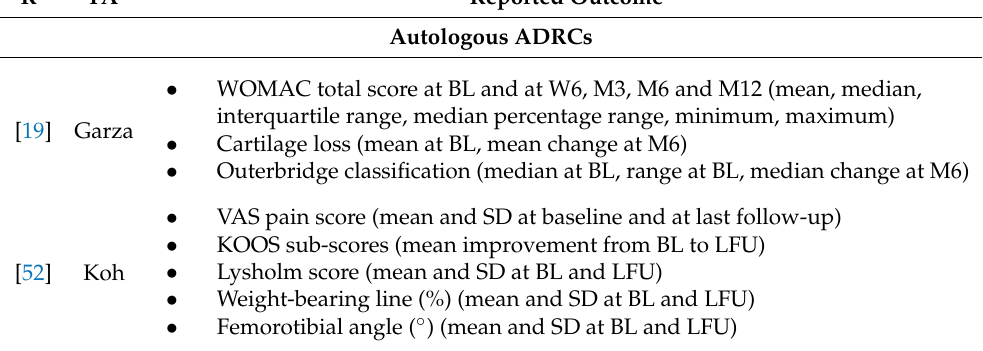
Table 11. Reported outcome in studies on treatment of primary knee osteoarthritis with autologous, adipose-derived regenerative cells, or autologous, adipose-derived stem cells listed in Table 10. R